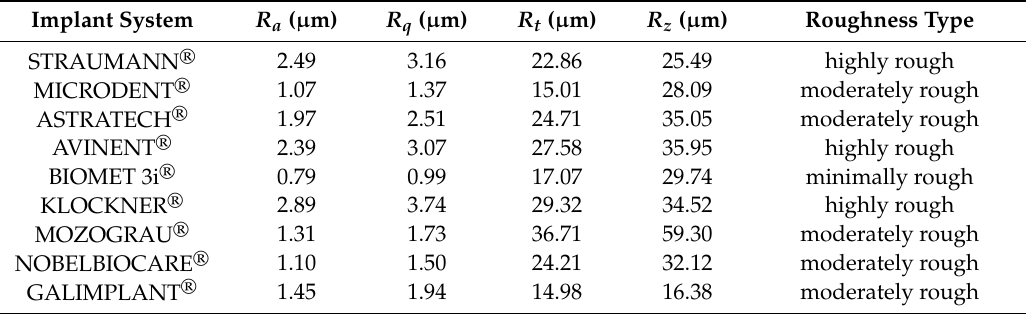
Table 2. Mean values of the roughness parameters evaluated for each implant system and the implant surface classification according to the degree of